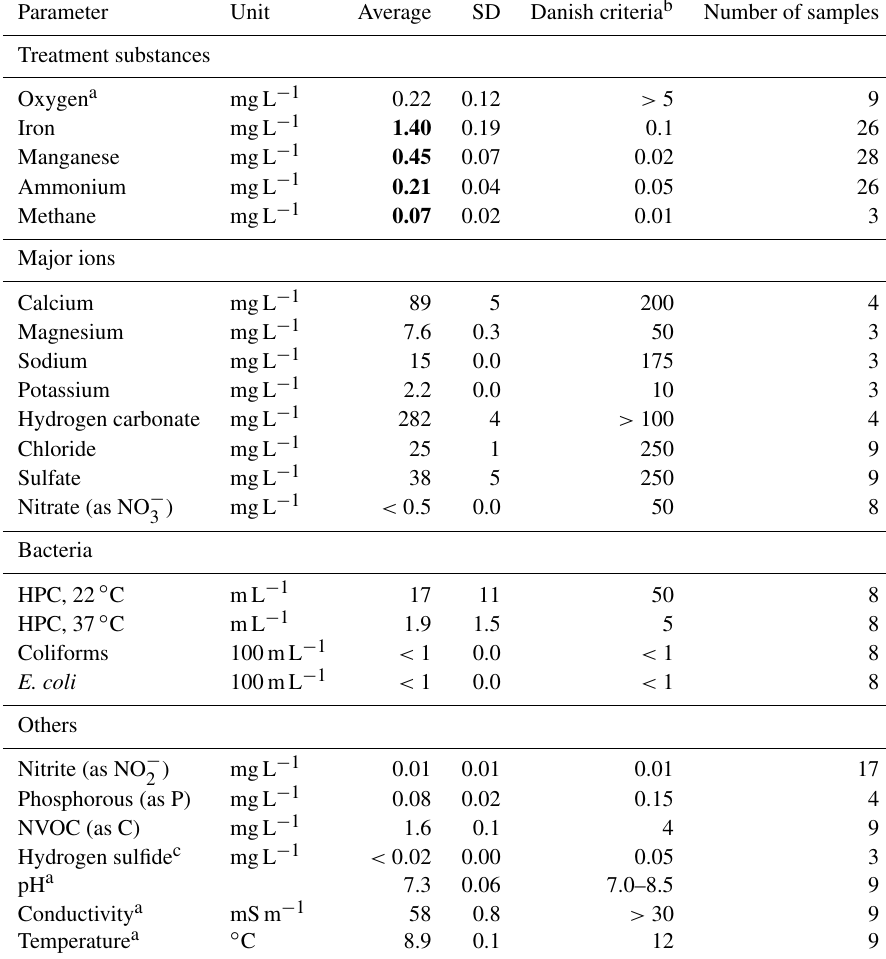
Bold font indicates concentrations above Danish drinking water criteria. a Field measurements. b Criteria for water exiting the waterworks (BEK 802, 2016). c Very faint hydrogen sulfide odor is detectable at the